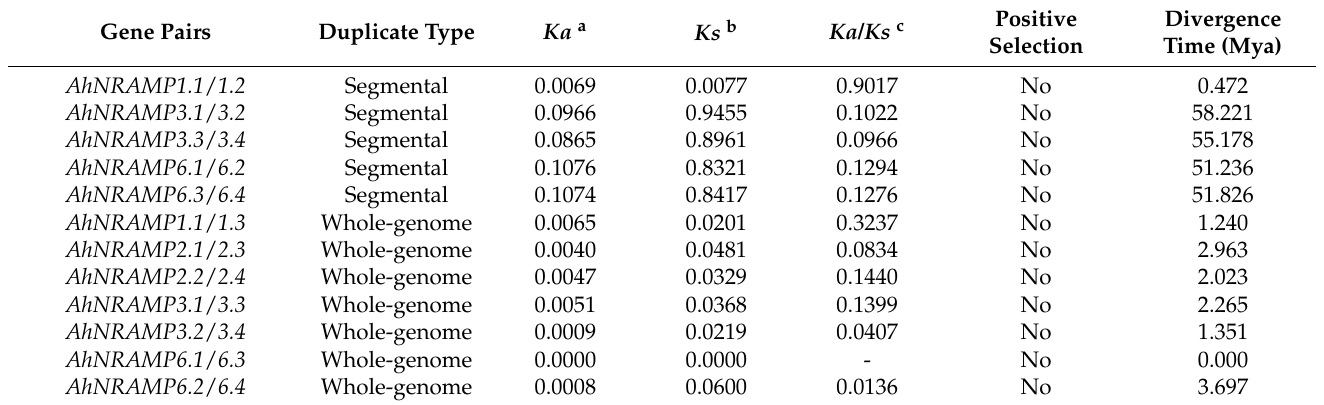
Table 2. Ka / Ks analysis of all gene duplication pairs for AhNRAMP genes.